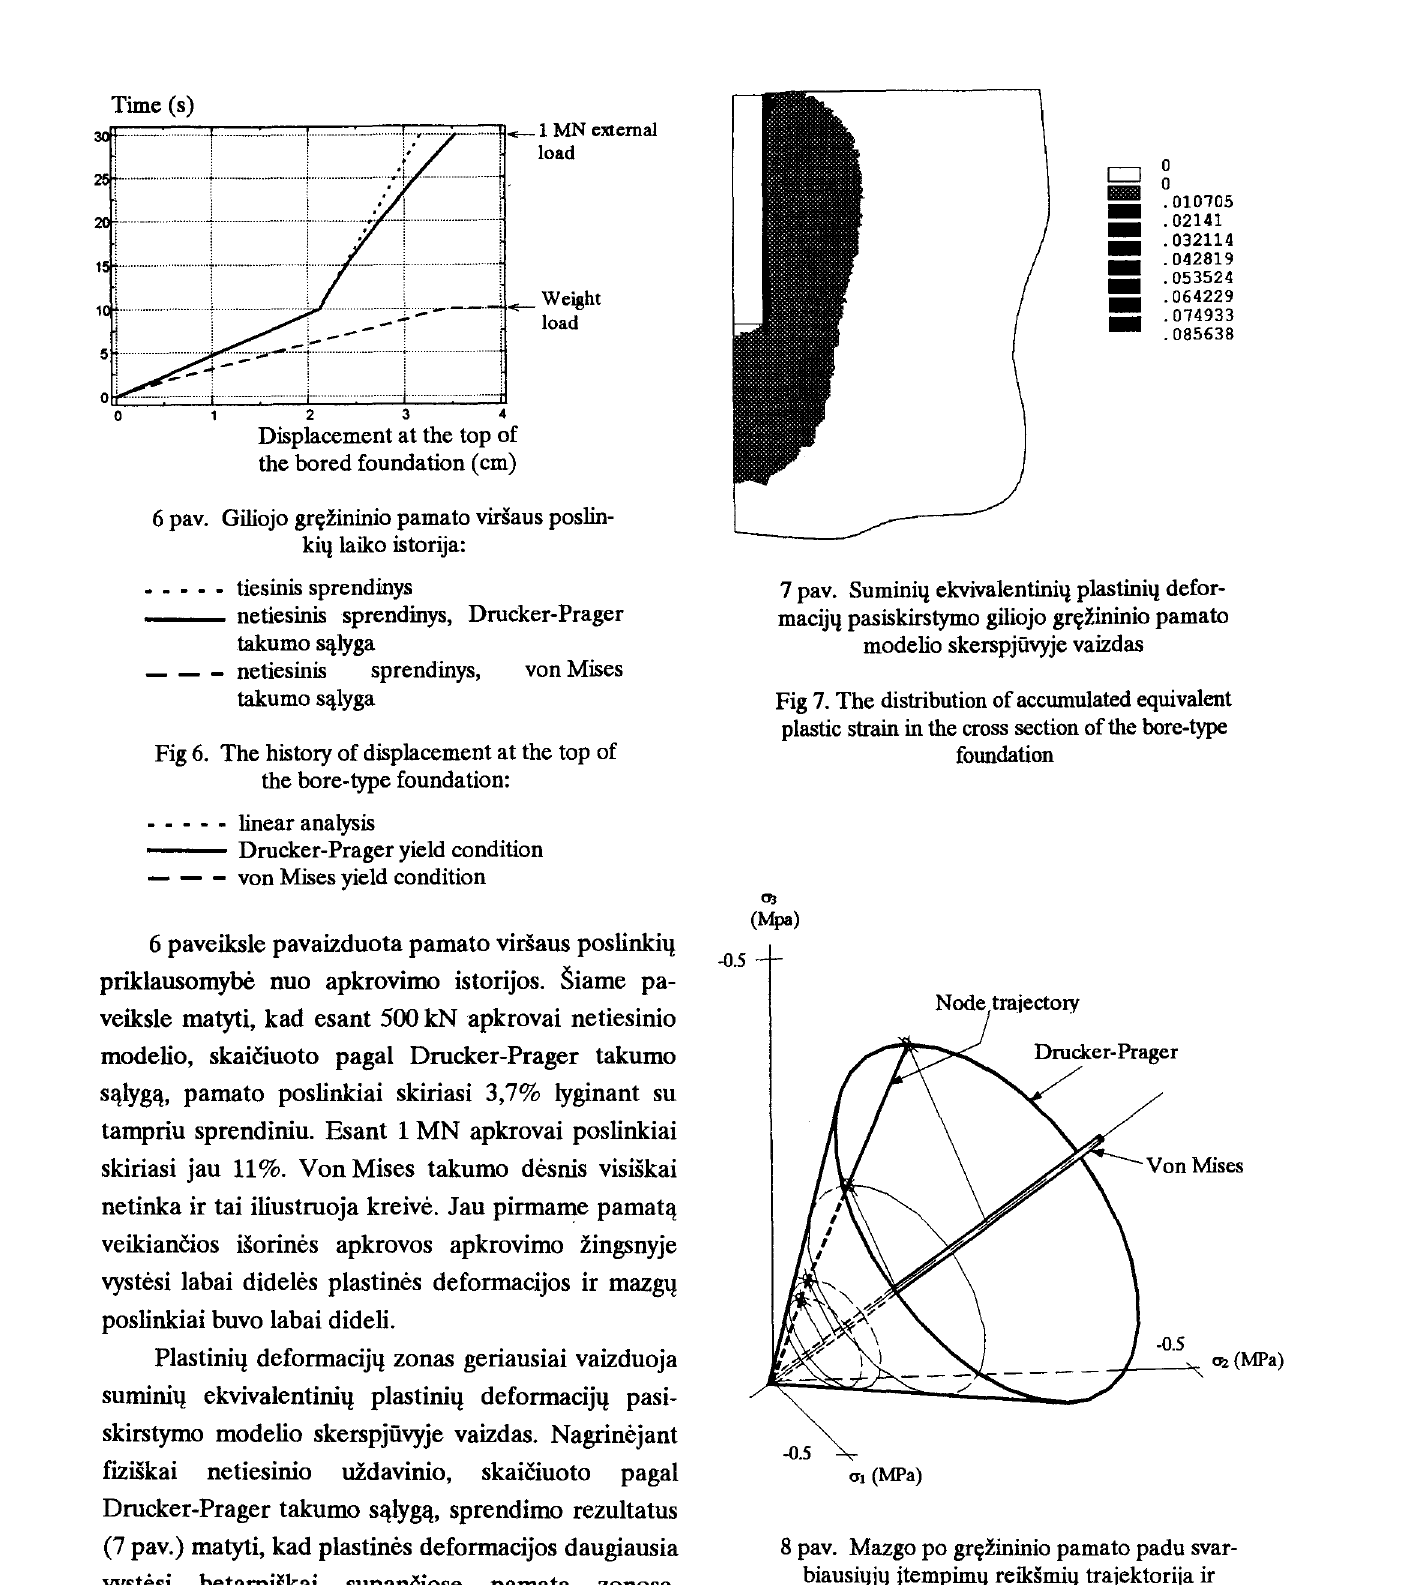
Fig 7. The distribution of accumulated equivalent plastic strain in the cross section of the bore-type foundation